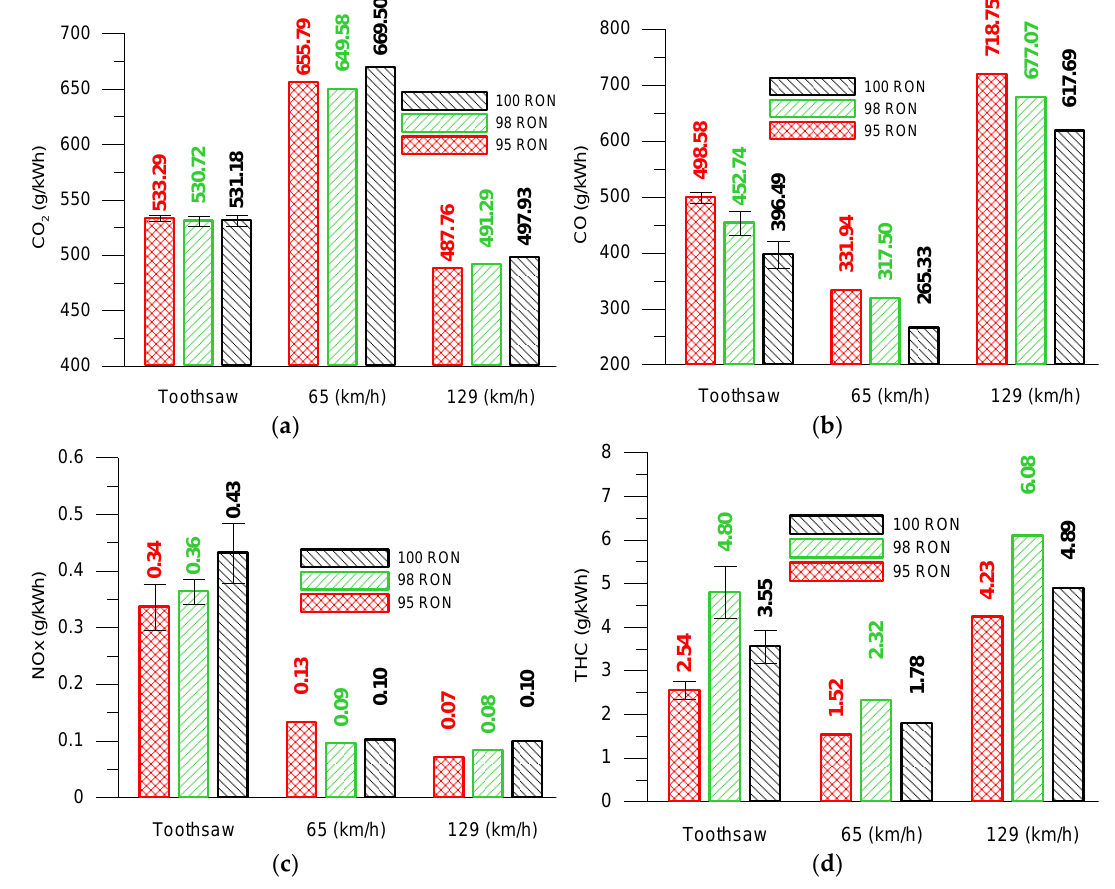
Figure 9. CO 2 ( a ), CO ( b ), NOx ( c ) and THC ( d ) emissions.